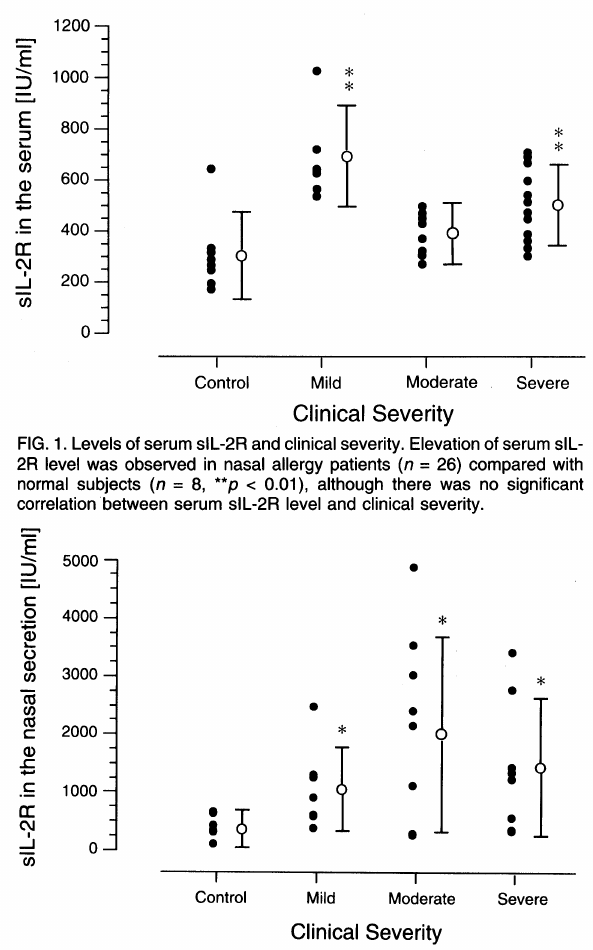
FIG. 2. Levels of slL-2R in the nasal secretions and clinical severity. The slL-2R level of the nasal secretions was elevated in the nasal allergy patients (n 26) compared with the normal subjects (n 9) (*p < 0.05). There was no significant correlation between slL-2R concentration in the nasal secretions and clinical severity.